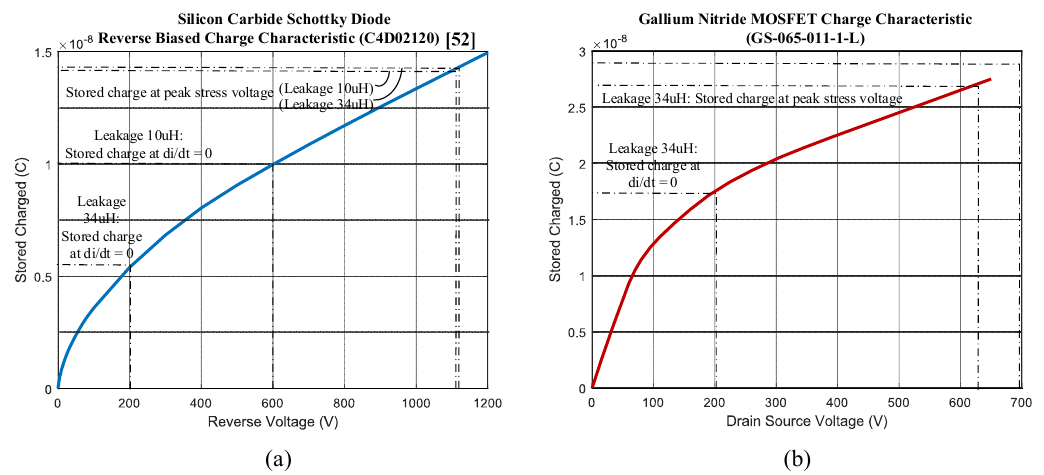
Figure 8. Rectifier charge relationship to voltage (from manufacturer datasheet) ( a ) Charge character- istic of SiC Schottky Diode C4D02120 [52] ( b ) Charge characteristic of GaN MOSFET GS-065-011-1-L.